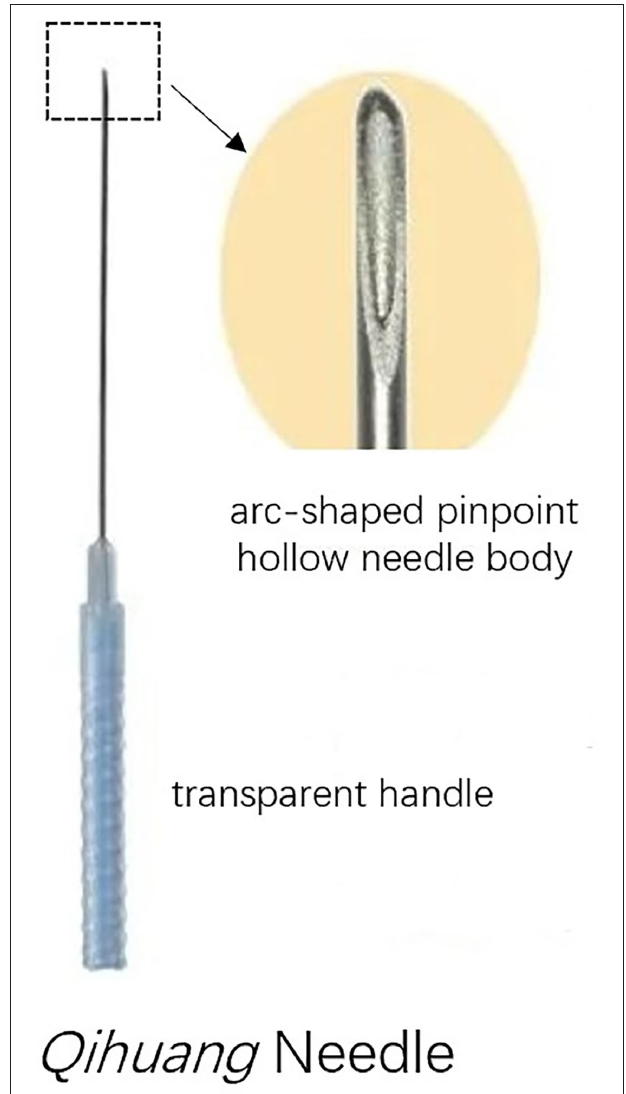
FIGURE 3 | Qihuang